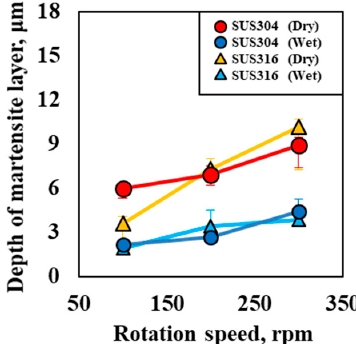
Figure 8. Depth distribution of martensitic transformations as a function of rotation speeds for SUS304 and SUS316 blocks under dry and wet conditions.